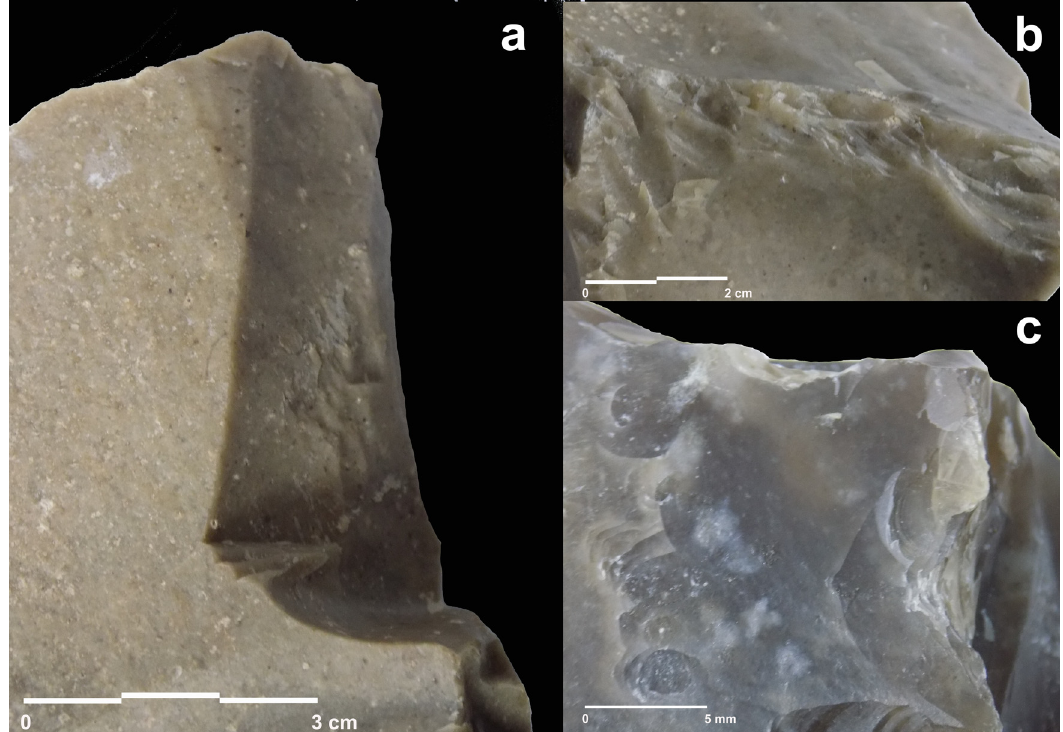
Figure 5: Examples of execution mistakes documented in Casa Montero cores: ( a ) deep hinges, ( b ) stacked unproductive hitting, and ( c ) tracks of Hertzian cones due to lack of accuracy. Photograph: N.